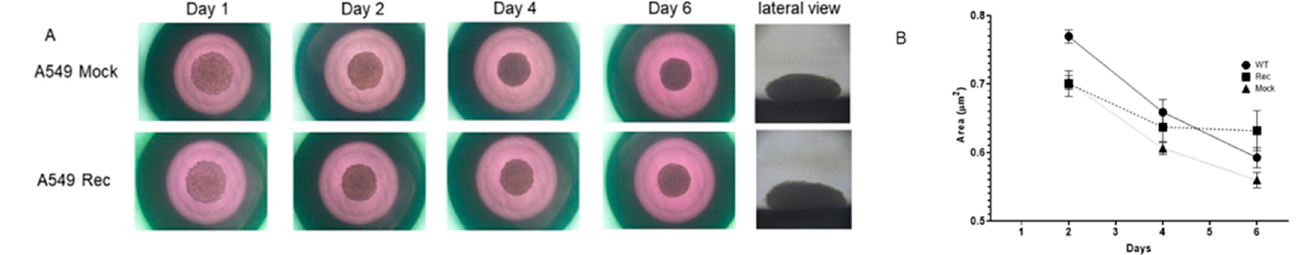
Figure 3. Comparisons of the mean sizes of 3D spheroids of WT, A549 MCOK and A549 Rec. In panel ( A ), representative phase contrast microscopy images of A549 MOCK and A549 Rec are shown (horizontal views at Day 1, 2, 4 and 6, and lateral views at Day 6, scale bar; 100 μ m). The mean sizes of the 3D spheroids of WT, A549 MOCK and A549 Rec were measured at Day 2, Day 4 and Day 6, and plotted in panel ( B ). Experiments were repeated in triplicate using fresh preparations (n = 10 spheroids each). All data are expressed as the mean ± the standard error of the mean (SEM). Statistical significance was evaluated by ANOVA followed by a Turkey’s multiple comparison test.